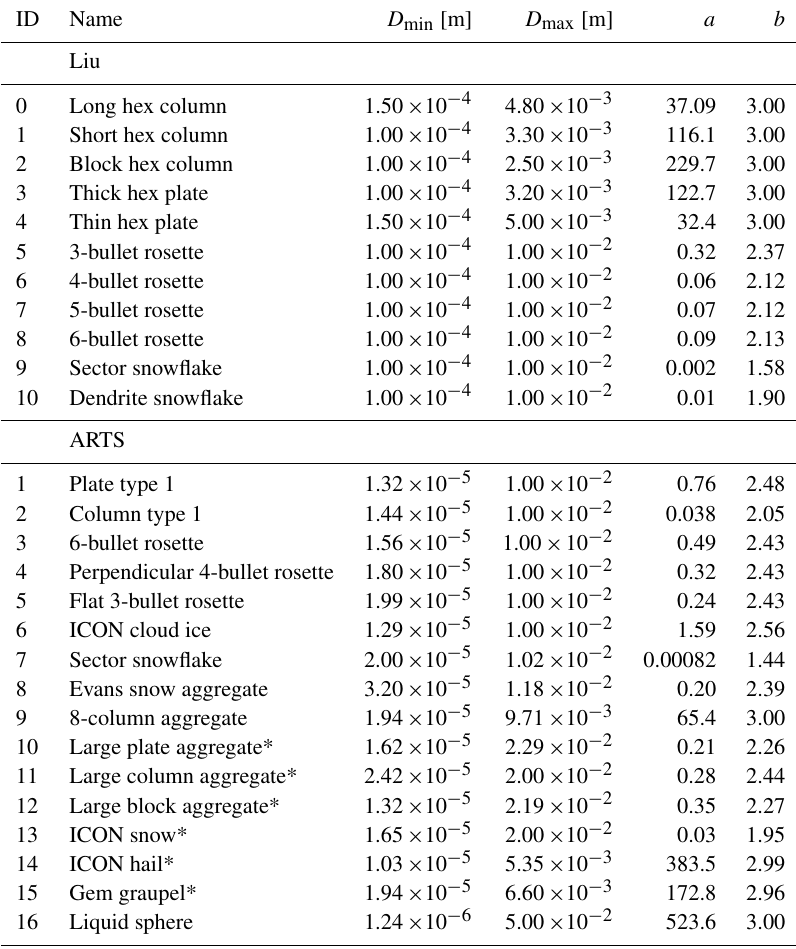
Table 3. Particles available from the Liu (2008) and ARTS (Eriksson et al., 2018) databases.